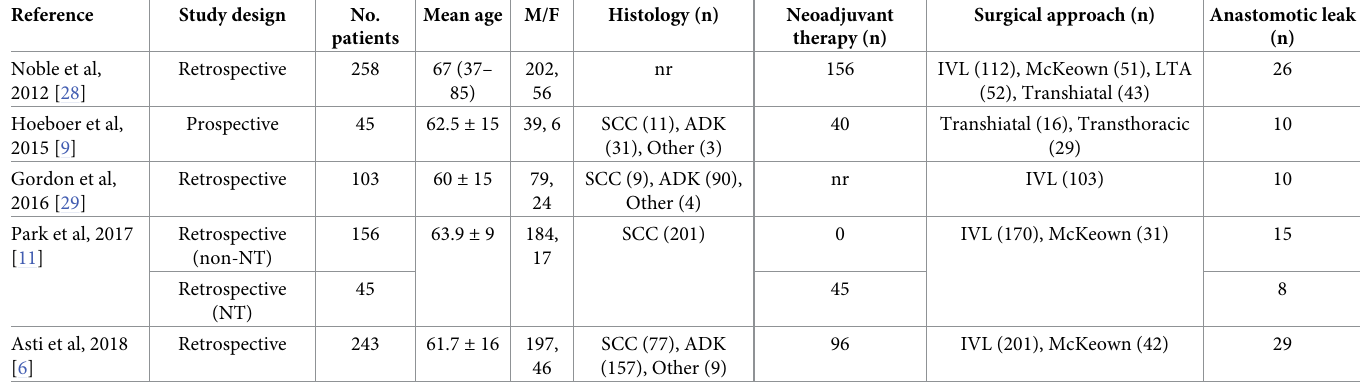
Table 2. Summary of the studies included in the meta-analysis. nr: not reported. SCC: Squamous cell carcinoma. ADK Adenocarcinoma. IVL: Ivor-Lewis esophagect- omy. LTA: left thoracotomic approach. Reference